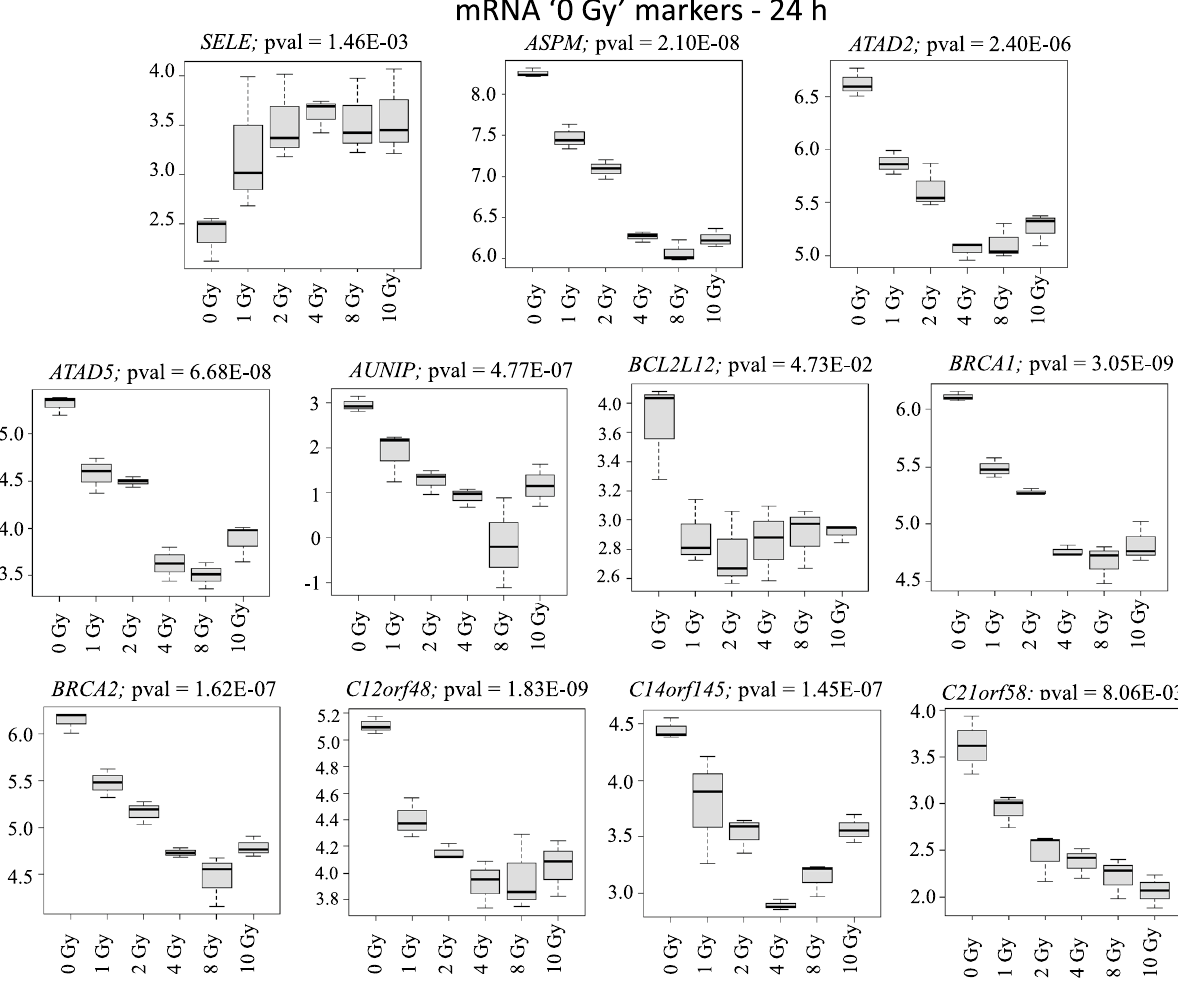
Figure 3. Radiation responsive mRNAs at 24 h for differentiating 0 Gy from all the doses classes. The 11 most significant mRNAs out of the 93 mRNAs at the intersection of all doses in supplementary Fig. 2A were selected as 0 Gy-24 h markers. Box-plots were generated in R. Y-axis shows the normalized read-counts and X-axis represents dose classes for 24 h smaller replicate size and large numbers of dose-groups, a classification and prediction analysis was not per- formed. Dose-classification on these 93 mRNAs was performed using recursive partitioning for classification, PRDM1 , SELE , SERPINE2 and SULT1A1 ) were most significantly differentially expressed in 0 Gy versus all the other dose points and could potentially serve as exposure/no-exposure markers at the 72 h (Fig. 5). Five qRT-PCR results are shown in supplementary Fig. 5. 0 Gy markers were identified from miRNA and lncRNA data as well. Two miRNAs (miR-128-1-5p and miR-27a-5p) differentiated 0 Gy from all other doses at the 24 h